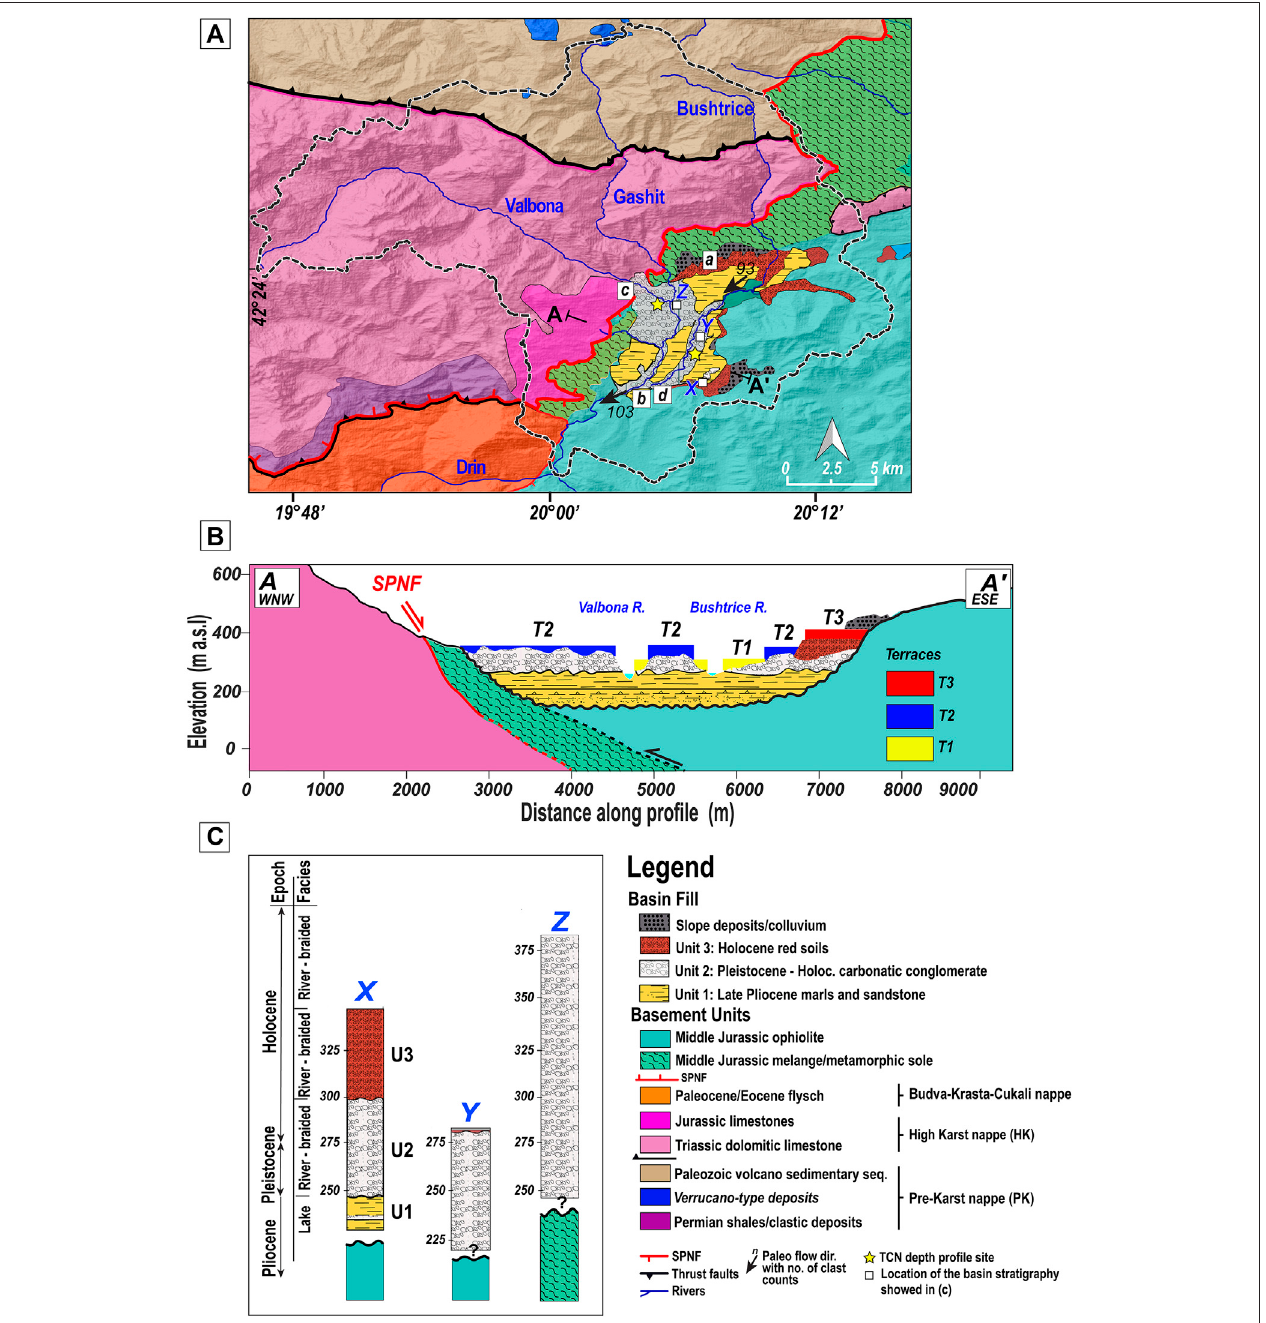
FIGURE4| TectonicmapandstratigraphyoftheTropojaBasin: (A) Lithostratigraphicmapofthestudyarea.Theblackdashedlinerepresentsthedrainageareaof thebasincatchmentatthecon fl uencewiththeDrinRiver.Traceofthegeologicpro fi leA-A ’ shownin (B) .Majorriversareshowninblue.Theterracesin(b)havethesame colourasin Figure3 .Labelsa – darelocationsofpicturesin Figure5 ;(b)Cross-sectionofthebasinwithbedrock,basin fi lland fl uvialterraces; (C) Stratigraphiccolumns at three locations X, Y, Z shown in (a).